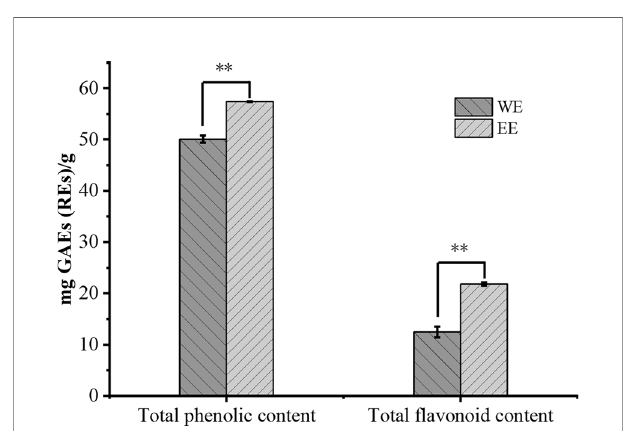
FIGURE 2 | Total phenolic and fl avonoid contents of WE and EE, ** p <